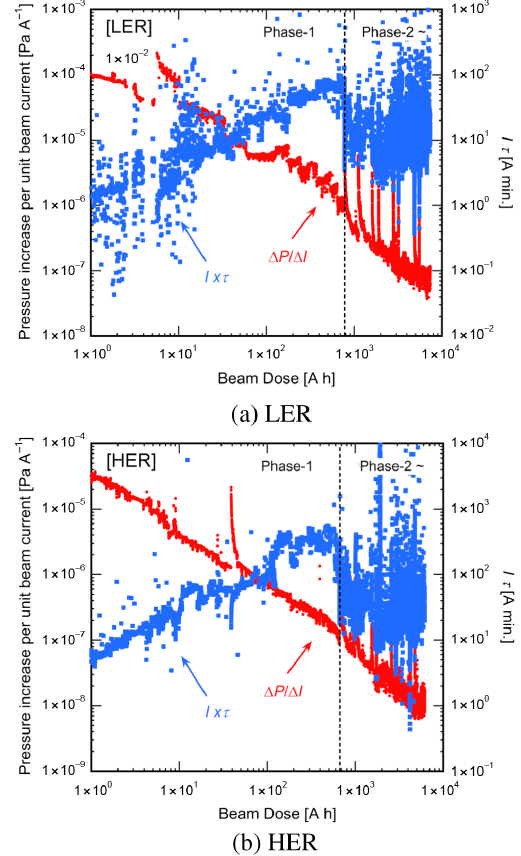
FIG. 11. Behaviors of pressure increase per unit beam current ( Δ P= Δ I ) and I τ as a function of beam dose from 2016 for (a) LER and (b)